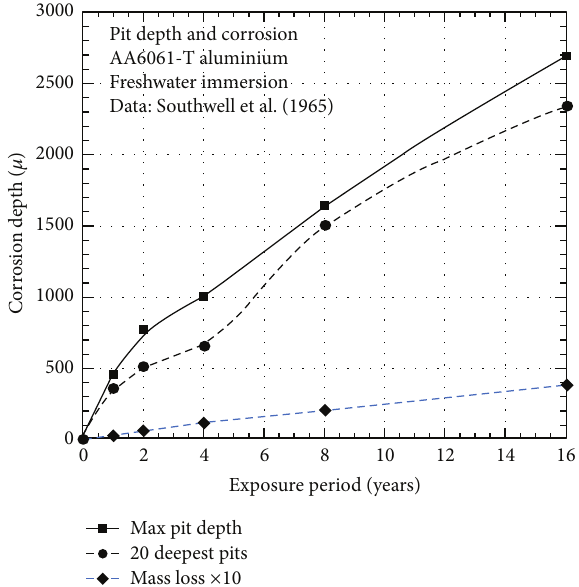
Figure 10: Data and fitted trends for AA1100 exposed to freshwater immersion conditions (Gatun Lake, PCZ). The changeover to mode 2 occurs at about 3 years of exposure. Data from Southwell et al. [2].